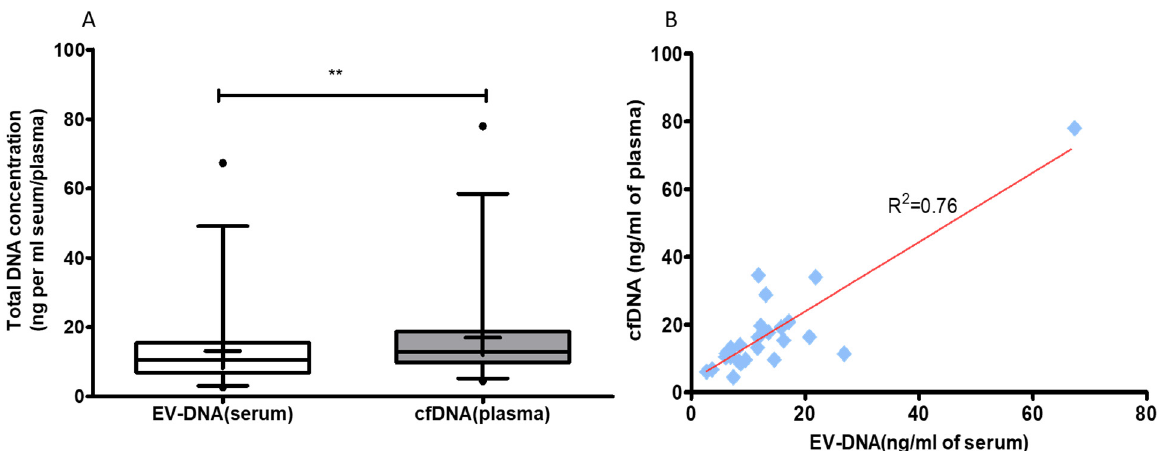
Figure 2. Total concentration of EV-DNA and cfDNA from colon carcinoma cases. ( A ) Box plot shows the comparison of total DNA concentration in EV-DNA and cfDNA. The total DNA concentration was more in cfDNA than EV-DNA. ( p value = 0.002). Wilcoxon matched pairs signed test; whiskers represents 5th and 95th percentile and mean shown by + in box plot. ( B ) Scatter plot shows correlation between total concentration of EV-DNA and cfDNA ( p value < 0.001, R 2 = coefficient of determination; blue squares represent EV-DNA and cfDNA concentration). ** refers to p ≤ 0.01.